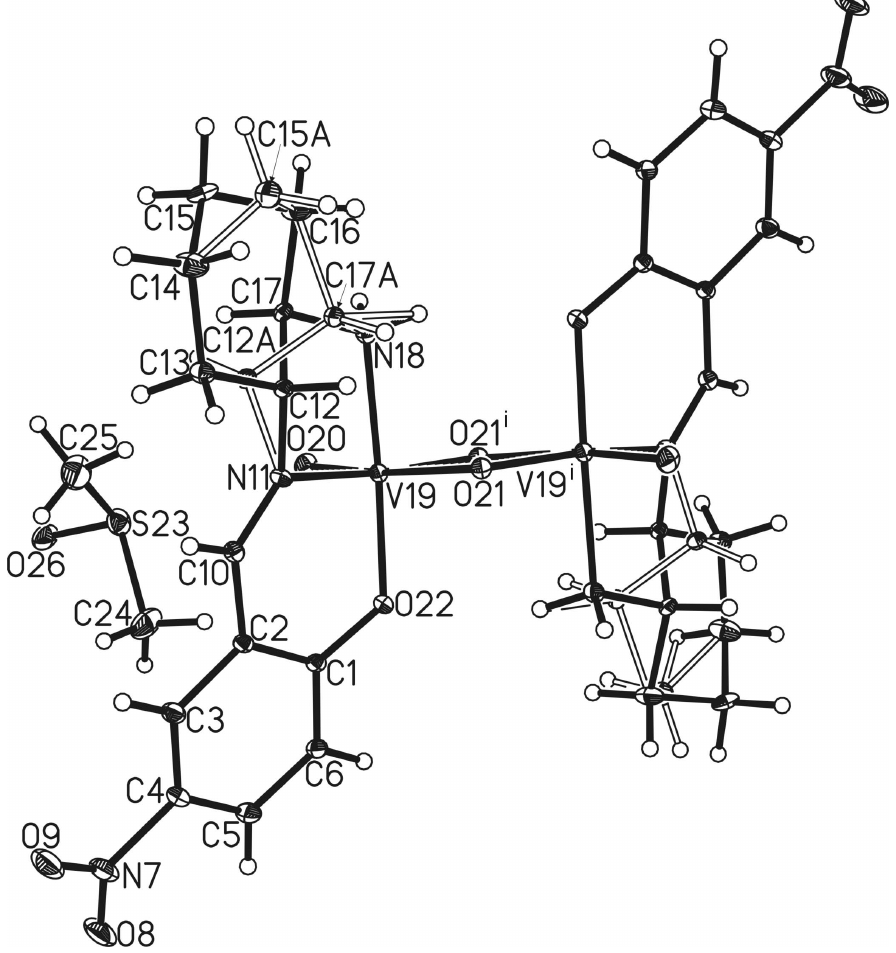
Figure 1 The molecular structure of the title compound, with displacement ellipsoids drawn at the 25% probability level. Disordered parts are shown by open bonds. [Symmetry code: (i) - x , - y + 1, - z +